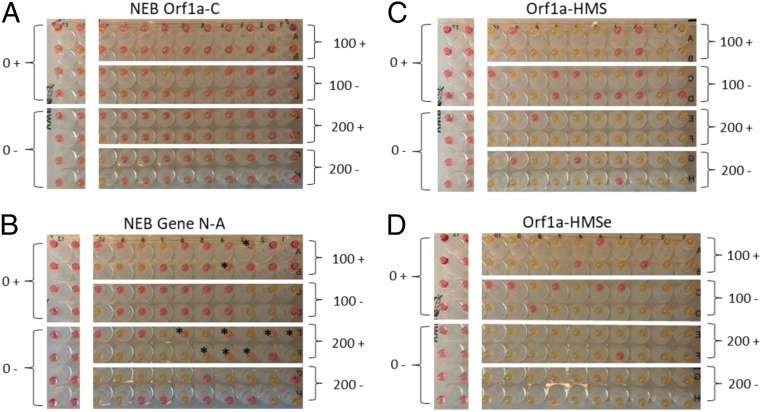
Assessment of GuSCN effects on sensitivity of colorimetric RT-LAMP assays. Colorimetric RT-LAMP reactions run with the number of control RNA copies (0, 100, or 200) noted. Reactions were run with 50 mM GuSCN (+) or without GuSCN (−) as noted. (A) NEB Orf1a-C primer set. (B) NEB Gene N-A primer set. (C) Orf1a-HMS primer set. (D) Orf1a-HMSe primer set. An * indicates reactions that were noticeably orange, but not completely yellow.